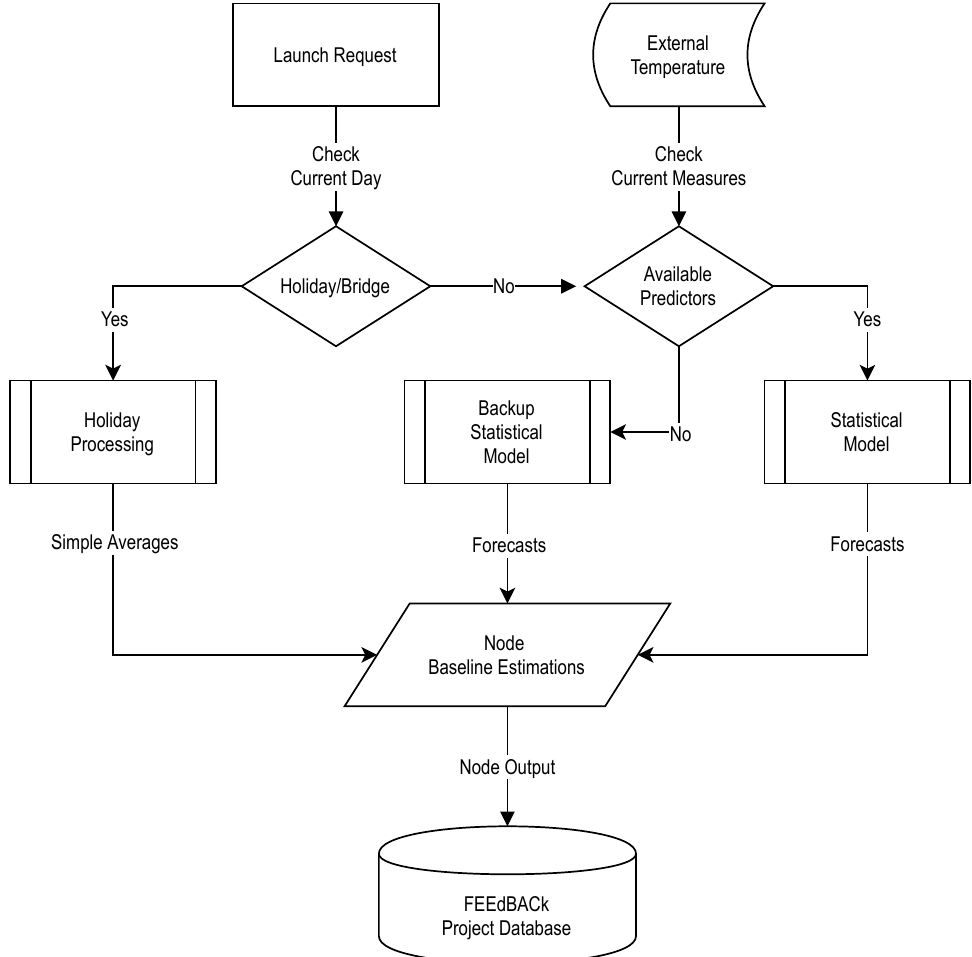
Figure 16. Block scheme of the load baseline estimation